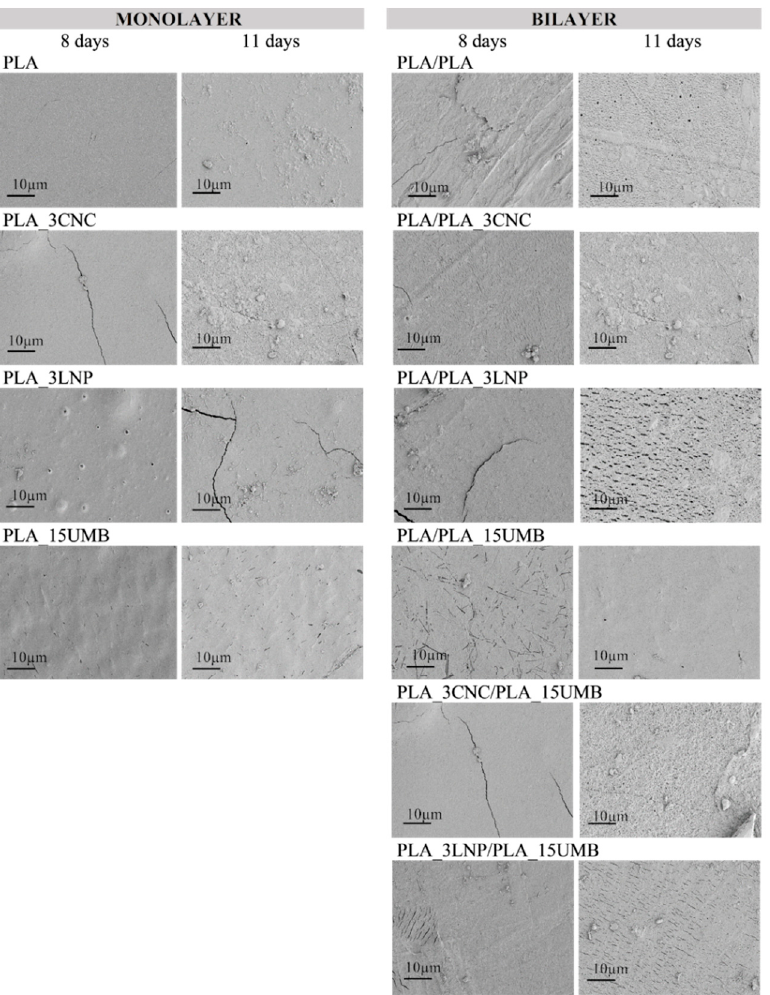
Figure 4. FESEM images of PLA (neat and nanocomposites) monolayer and bilayer film surfaces after eight and 11 days of incubation in composting conditions.